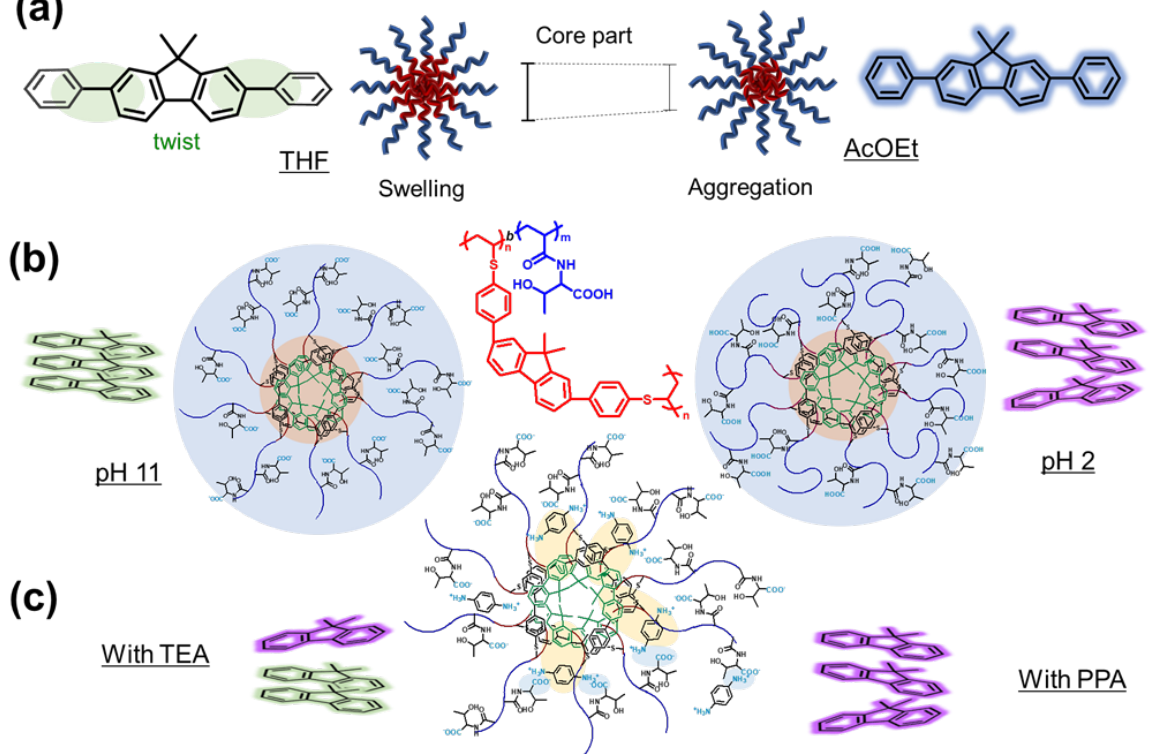
Figure 3. Proposed mechanism of the fluorescence property of NP(Fl) in ( a ) different organic solvents, ( b ) aqueous solutions at different pH values, and ( c ) aqueous solutions in the presence of amine compounds (TEA and PPD).